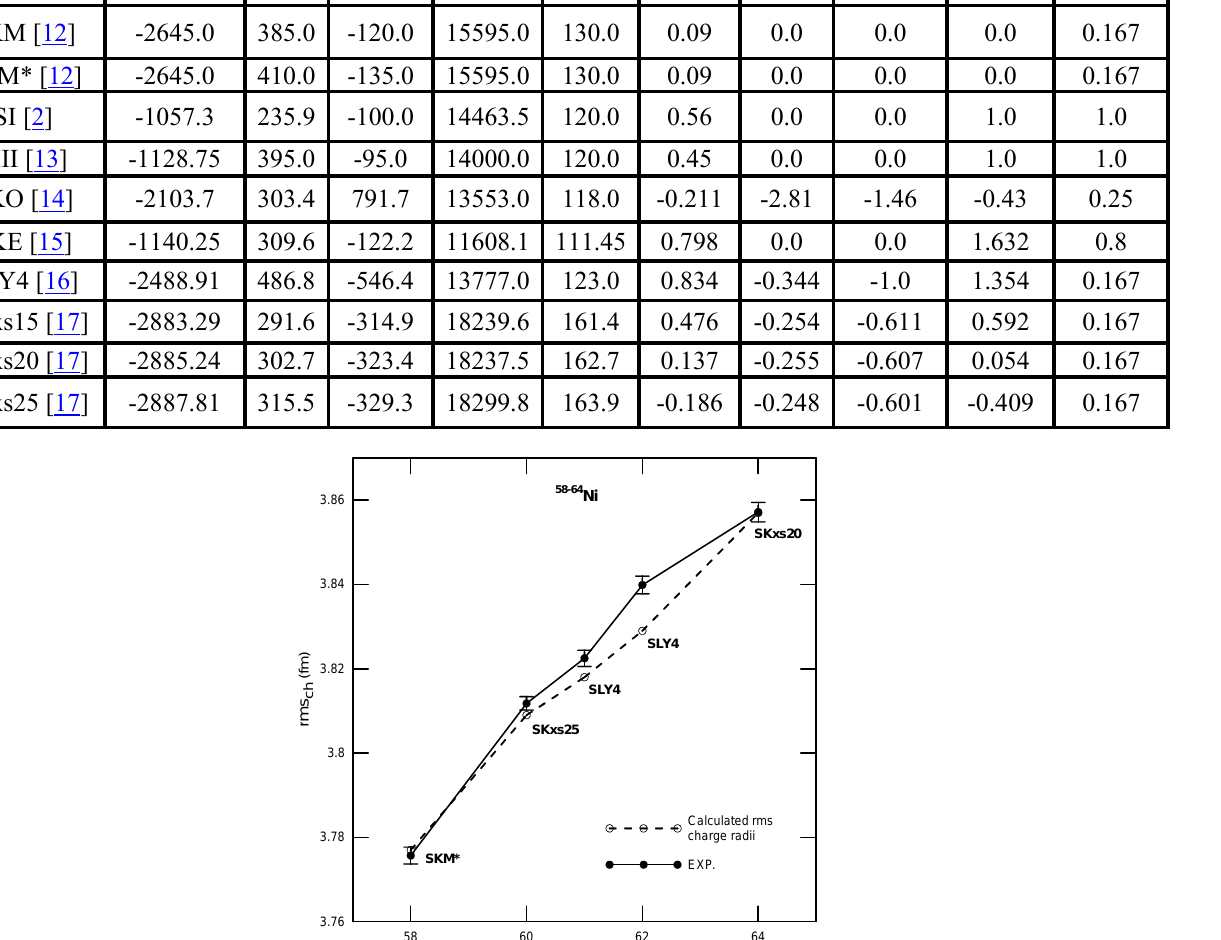
Fig. 1: Calculated rms charge radii for 58-64 Ni isotopes compared with the experimental data taken from Ref.